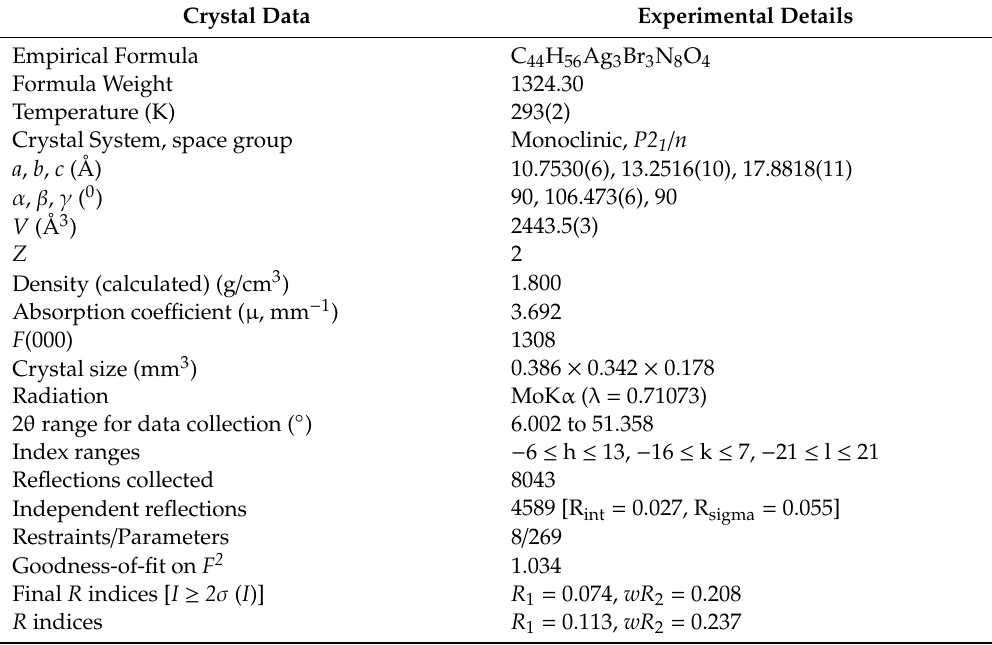
Table 1. Crystal data and experimental details for the Ag-NHC complex 1